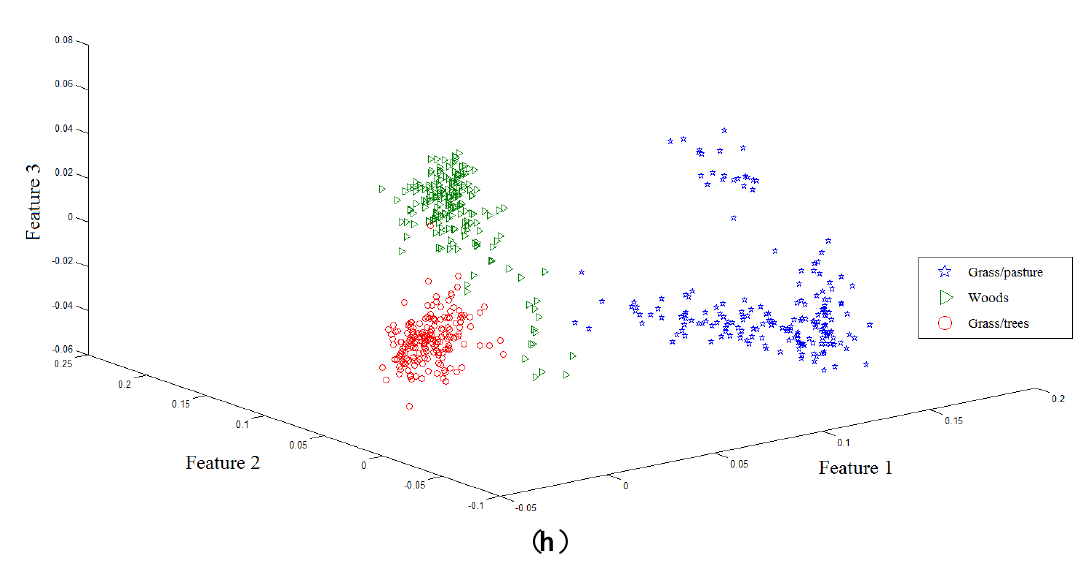
Figure 2. The first toy sample distributions projected on the first three axes using algorithms ( a ) PCA (principal component analysis); ( b ) LDA (linear discriminant analysis); ( c ) supervised LPP (locality preserving projection); ( d ) LFDA (local Fisher discriminant analysis); ( e ) NFLE (nearest feature line (NFL) embedding); ( f ) FNFLE (fuzzy nearest feature line embedding); ( g ) KNFLE (kernel nearest feature line embedding); and ( h ) FKNFLE (fuzzy-kernel nearest feature